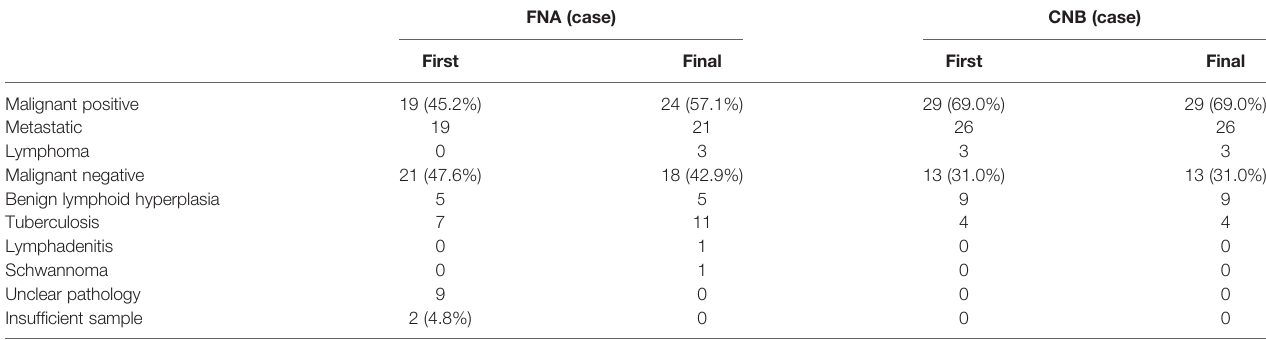
TABLE 2 | Pathological diagnosis in the FNA and CNB